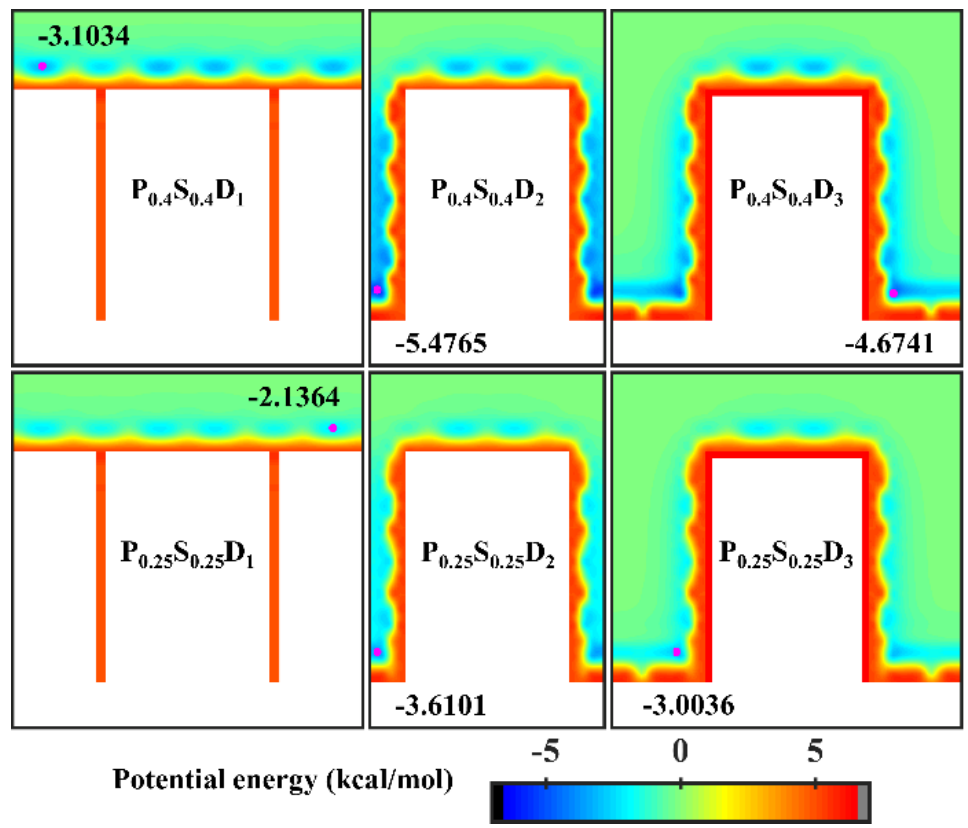
Figure 5. Equipotential curves of potential energy between water molecule and the nanopillar surfaces with uniform wettability. The minimum values of the potential energy are given in the figure and their positions are marked with a pink dot.